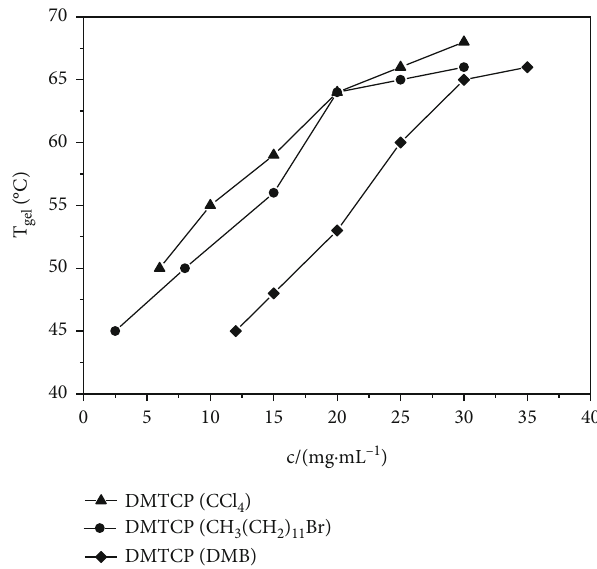
Figure 16: Gel-sol phase transition temperature diagram of DMTCP.